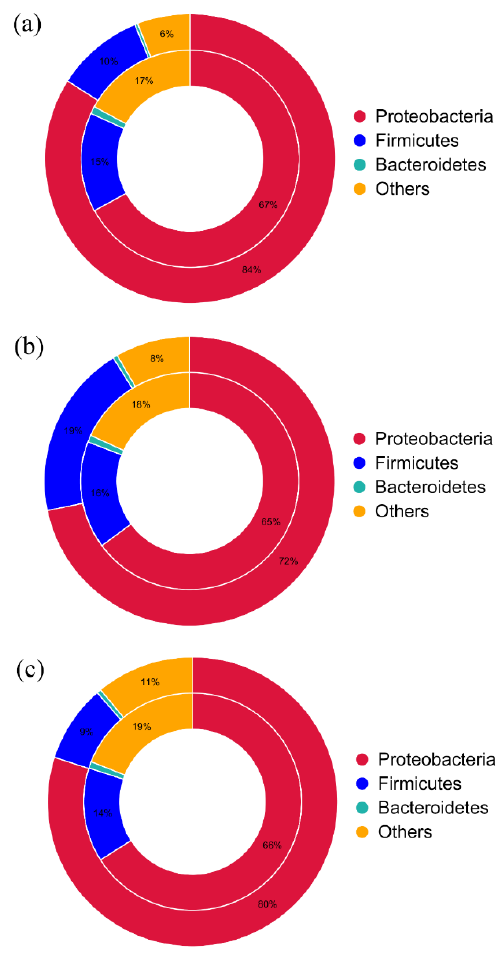
Figure 8. Comparison between the distribution of the ARGs (internal cycle) and the total microbial gene set (external cycle) at bacterial phylum level.